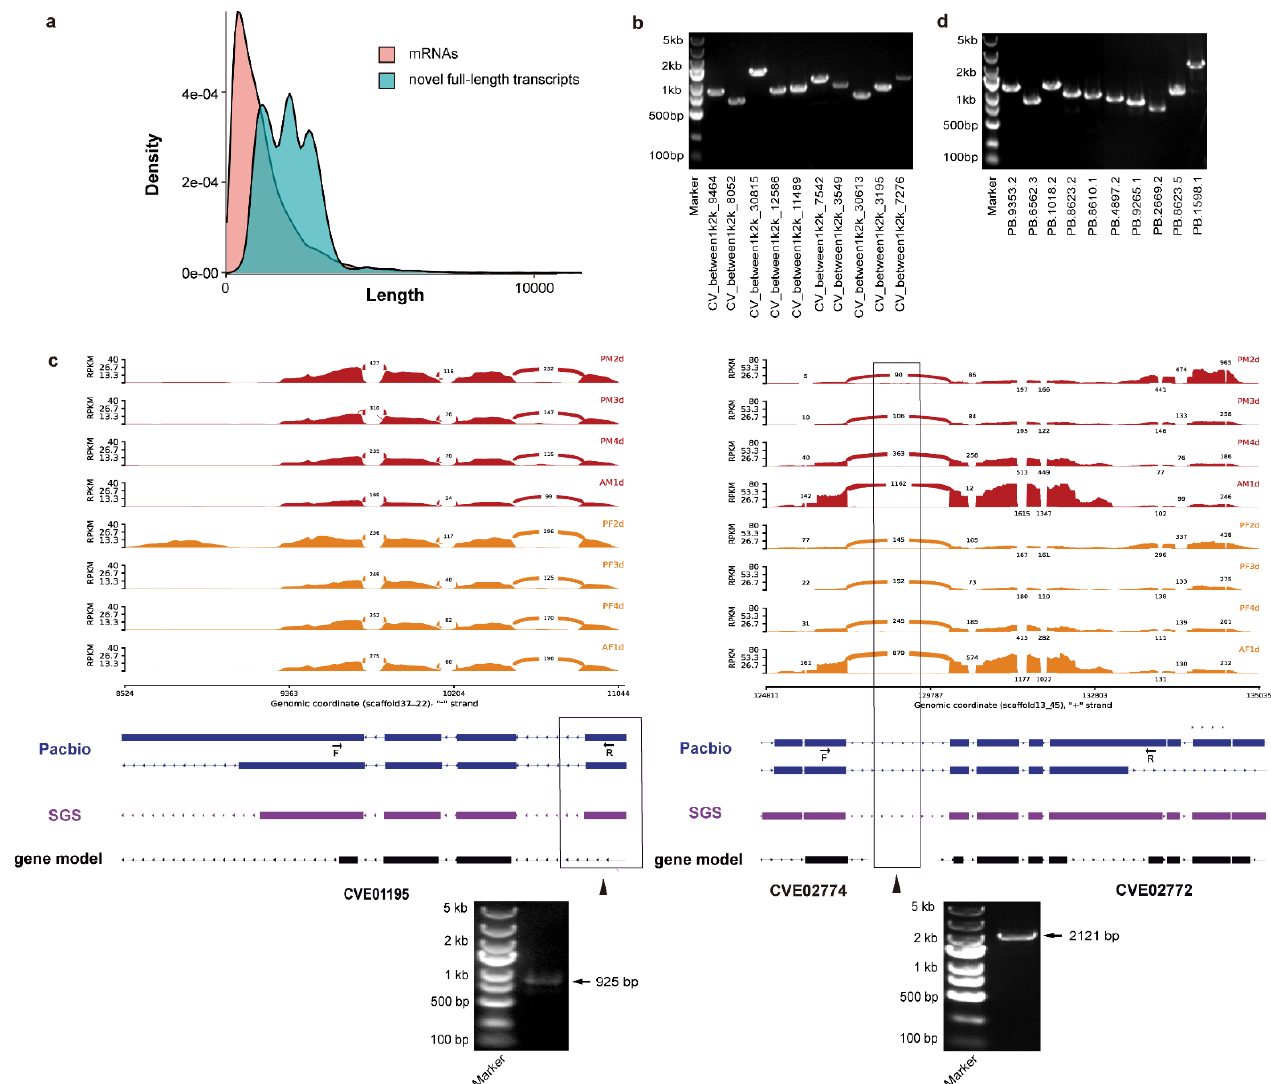
Figure 1. Identification of novel gene transcripts and a revised annotation of the C. vestalis genome. ( a ) The comparison of length distributions of novel full-length transcripts and mRNAs in the C. vestalis genome. Red: mRNAs, blue: novel full-length transcripts. ( b ) Ten novel transcripts were chosen at random and verified by RT-PCR. ( c ) Sashimi plot of two examples of falsely annotated genes in pharate adult and adult development of both sexes in C. vestalis . The thickness of the curves in red (male) and orange (female) crossing two splicing junction sites (SJ) represents the coverage degree of Illumina RNA-Seq reads, and the number of junction reads is marked in the middle of the splicing site. The RNA coverage was given as the log-transformed reads per kilobase of transcript per million mapped reads (RPKM) value. Blocks represent exons, and lines represent introns. The black rectangular box and arrow indicate an extra exon in gene CVE01195 and a junction region in mis-annotated genes (CVE02774 and CVE02772), respectively. Forward and reverse primers used in RT-PCR are marked as F and R, respectively. SGS, second-generation sequencing. ( d ) Ten full-length transcripts that overlapped mis-annotated genes were chosen at random and verified by RT-PCR.